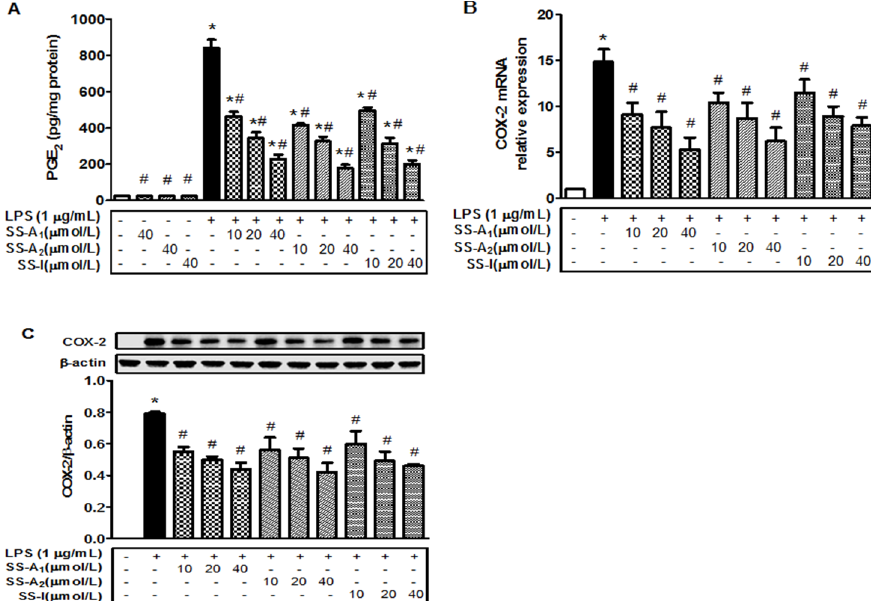
Figure 1. Soyasaponins blunt the LPS-induced release of inflammatory markers in macrophages. Cells were pre-treated with increasing amount of soyasaponins (A 1 , A 2 and I) for 30 min and then treated with LPS (1 m g/mL) for 16 h as noted. Some cells were treated with soyasaponins alone for the same amount of time. PGE 2 in the media was then quantified with enzyme immunoassays ( A ). Total RNA was isolated and COX-2 mRNA level was determined by using real-time PCR ( B ). Protein level of the COX-2 gene was evaluated with immunoblotting ( C ). Results represent means 6 SD of 3 independent experiments. *: P , 0.05 vs. control. # : P , 0.05 vs. LPS alone.